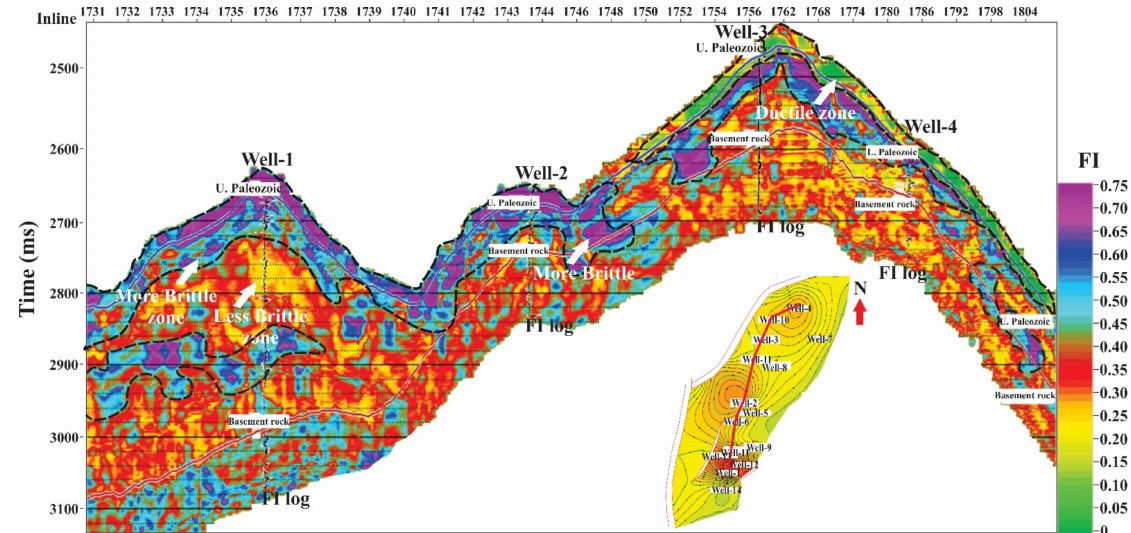
Figure 10. FI model seismic inversion profile across wells in the study area.